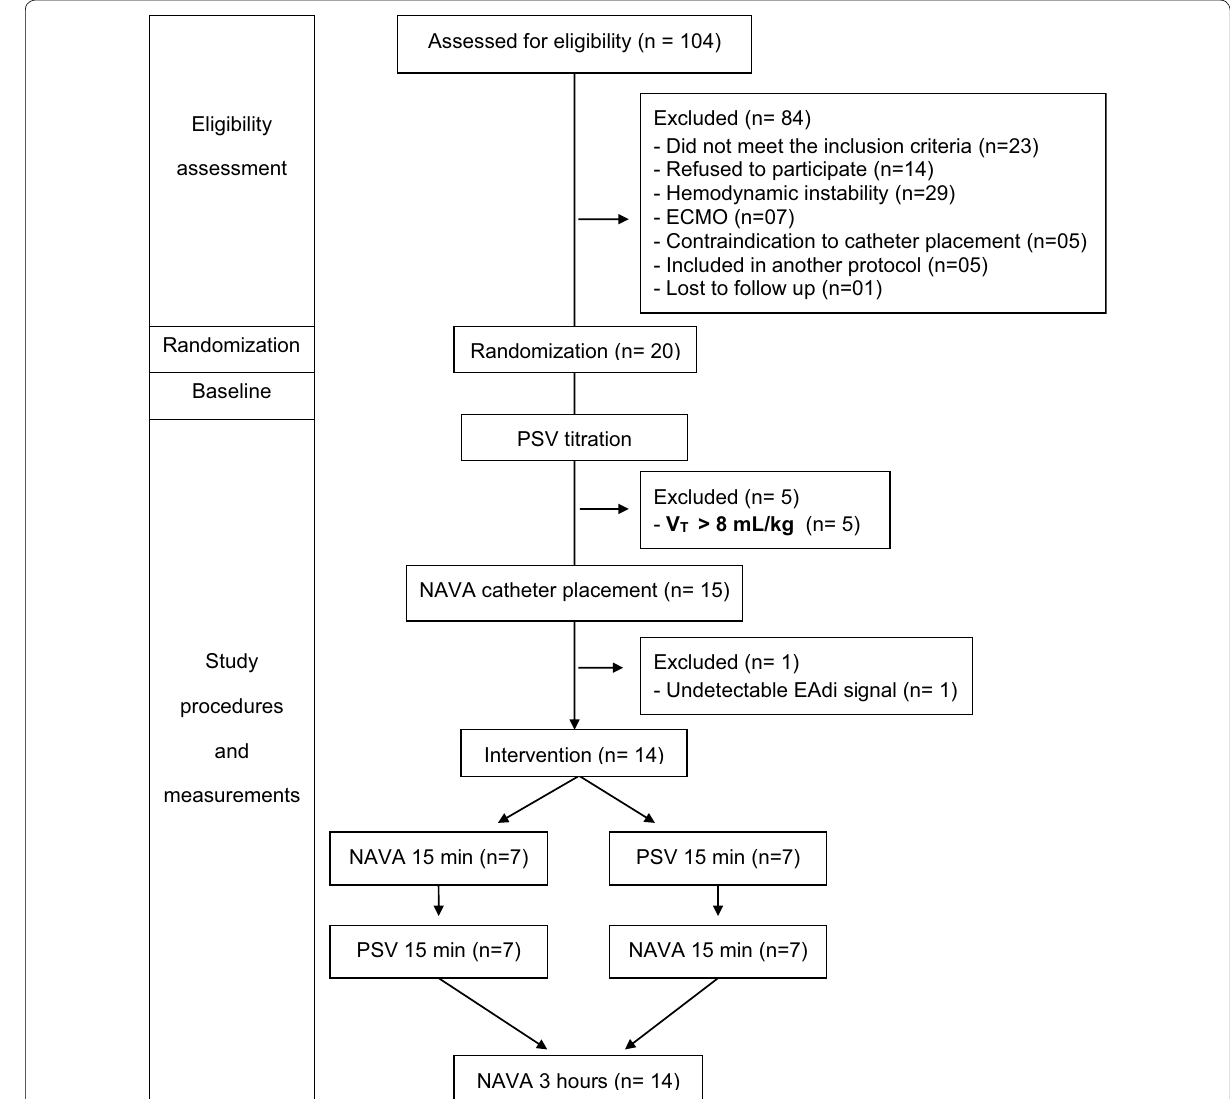
Fig. 1 Flow diagram of study patients and procedures. NAVA neurally adjusted ventilatory assist, PSV pressure support ventilation, EAdi electrical activity of the